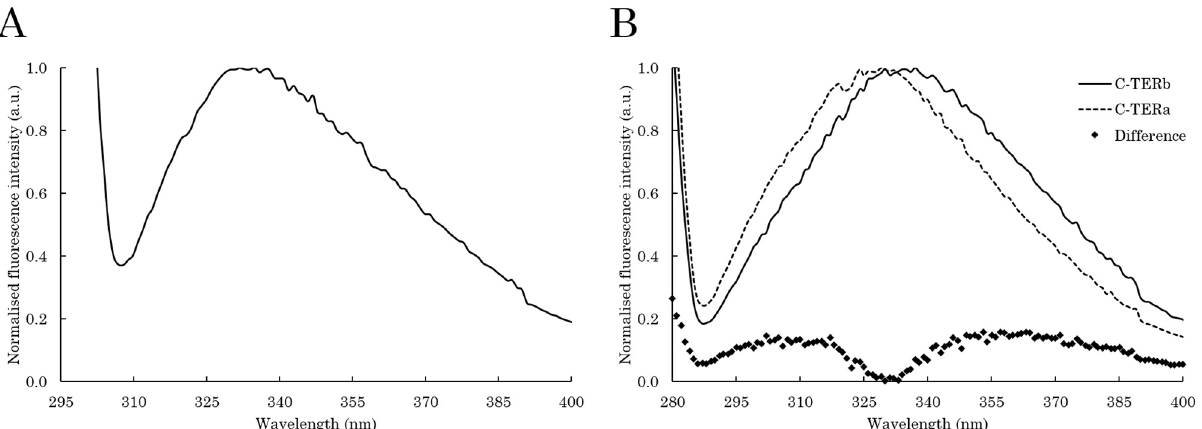
Figure 3. Intrinsic fluorescence spectra of C-TERb and C-TERa (C C-TER = 10 µ M) in TBS at ~20 ◦ C. ( A ) Normalised ITF spectrum ( λ ex = 295 nm, sw = 10 nm) of C-TERb. ( B ) Normalised ITyrF spectra ( λ ex = 275 nm, sw = 10 nm) of C-TERb (solid line) and C-TERa (dashed line) at the associated difference spectrum (diamonds).